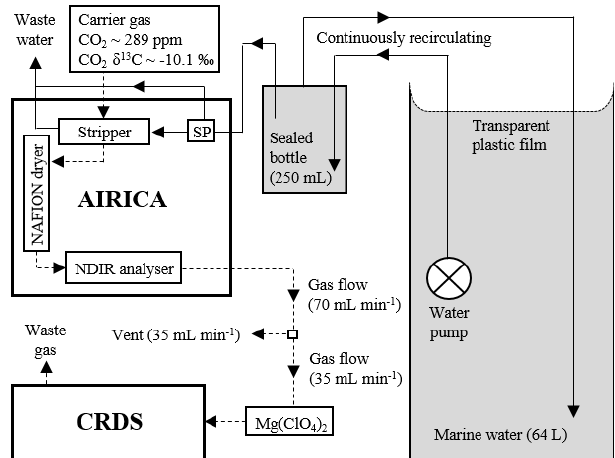
Figure 1. Schematic of the coupled Autonomous Infra Red Inor- ganic Carbon Analyser (AIRICA) and Cavity Ring Down Spec- trometer (CRDS) set up to autonomously and continuously measure DIC concentrations and δ 13 C-DIC values. Solid arrows indicate liq- uid flow and dashed arrows indicate gas flow. SP = syringe